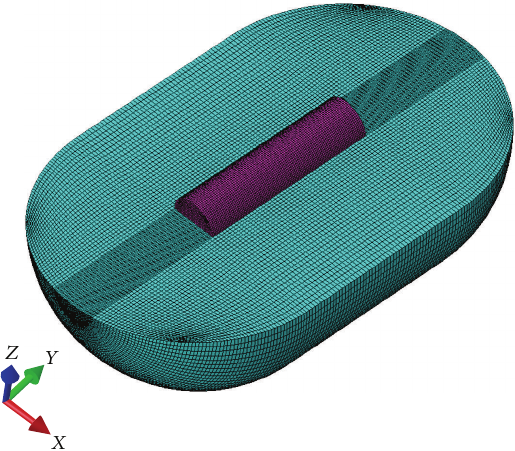
Figure7: Thefiniteelement model ofthecylindrical shelland